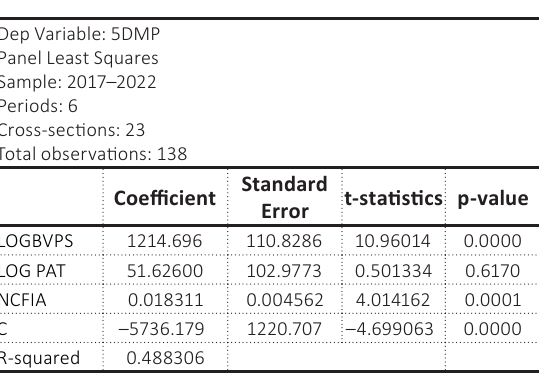
Table 6. Regression, post-Ind AS